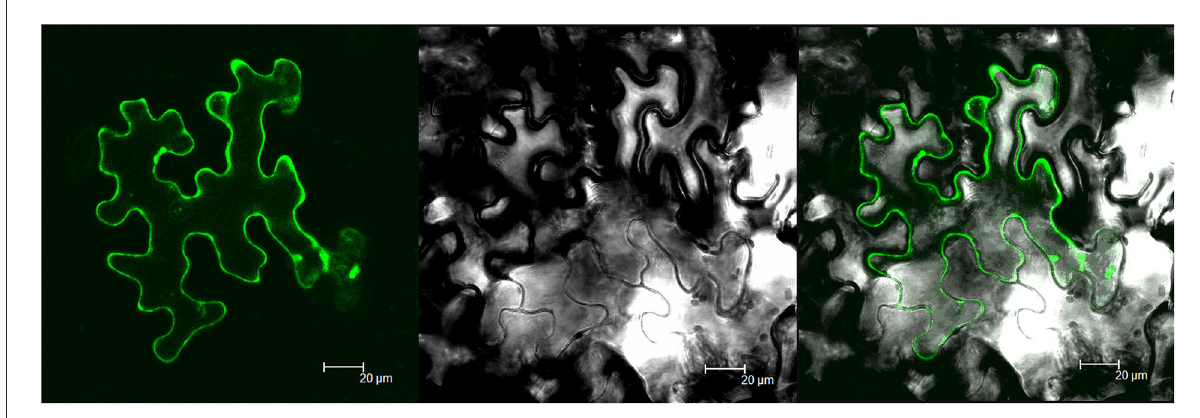
(Figure 1). However, predictions of CELLO 2.5 to find